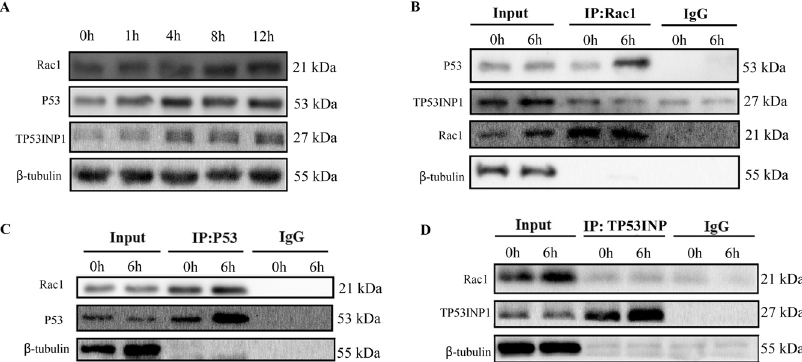
Fig. 4 Binding of Rac1 with P53 was induced by radiation. A MLE-12 cells were radiated with 10 Gy, and the expression of Rac1, P53, and Trp53inp1 were detected by Western blotting at a designed time (0, 1, 4, 8, 12 h after radiation). B At 6 h after radiation, immunoprecipitation was conducted to detect the binding of Rac1 with p53 and Trp53inp1, in which Rac1 was precipitated. C , D At 6 h after radiation, p53 ( C ) and Trp53inp1 ( D ) was precipitated, respectively, and then the expression of Rac1 was